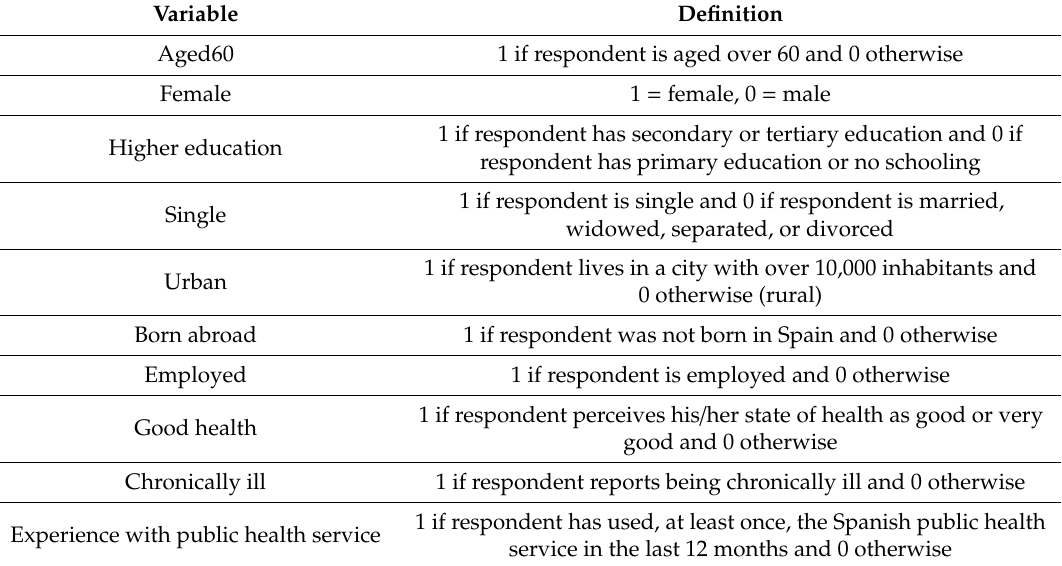
Table 2. Socioeconomic variables of respondents to analyse self-reported experience with the public Spanish health services in